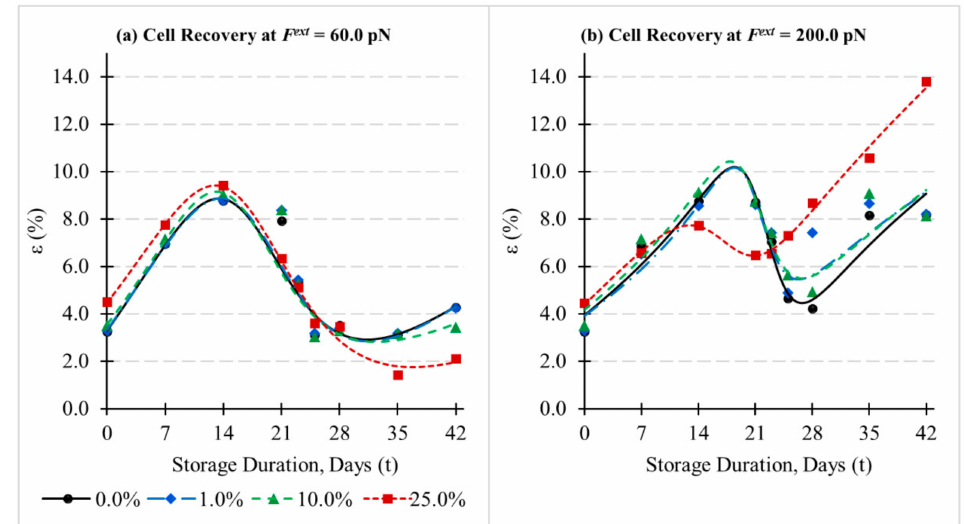
Figure 11. The error in cell dimensions ( ε ) of recovered stretched RBCs with 0%, 1%, 10% and 25% of defective vertical interactions ( A Vertical ) with respect to their analogous recovered cell state at optical tweezers stretching forces of ( a ) F ext = 60.0 pN and ( b ) F ext = 200.0